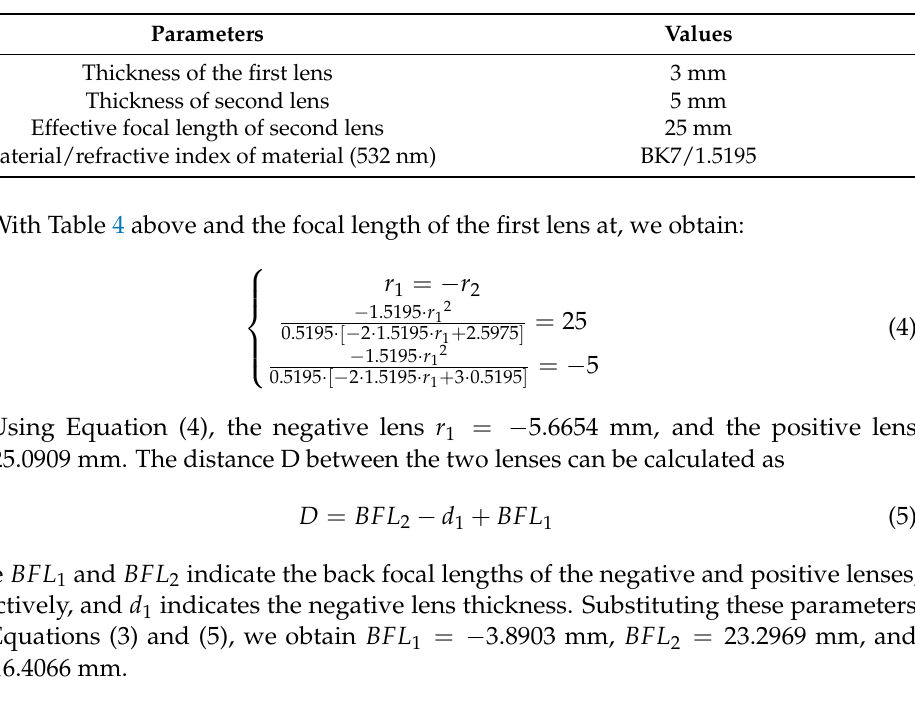
Figure 3. Galileo-type collimated beam expander. Table 4. Galileo collimated beam expander